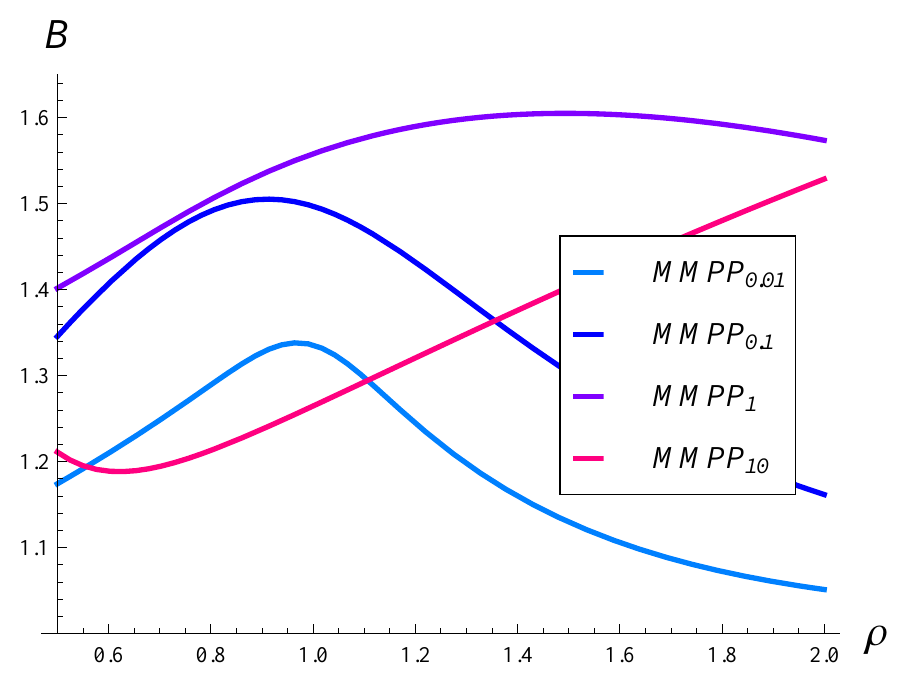
Figure 5. Burst ratio vs. the link load for arrival processes with different autocorrelations. Square root drop probabilities, i.e., r = 0.5.